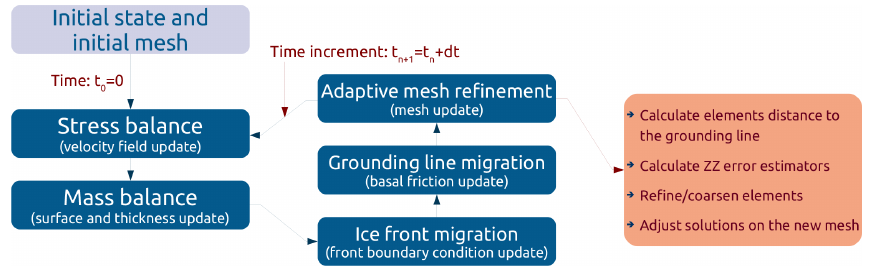
Figure 3. Solution sequence for ice sheet transient simulation with adaptive mesh